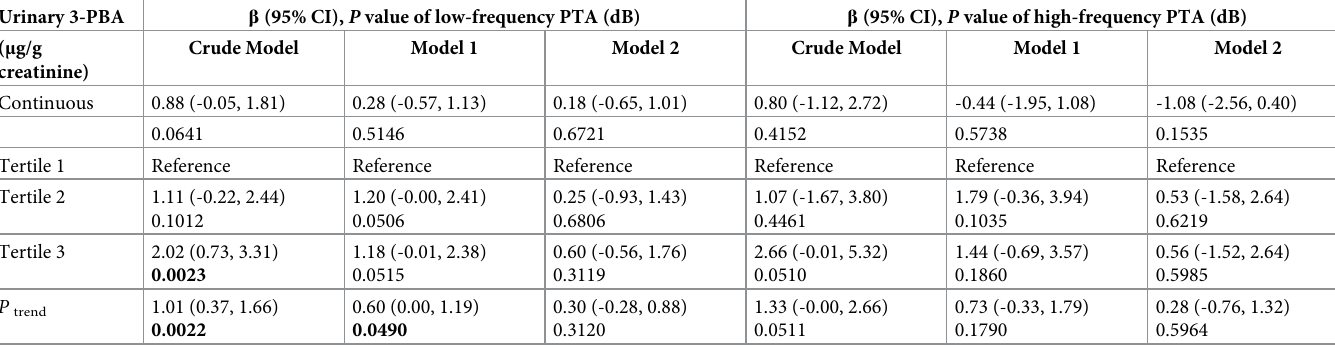
Table 3. Multivariable linear regression models for outcome of hearing thresholds.